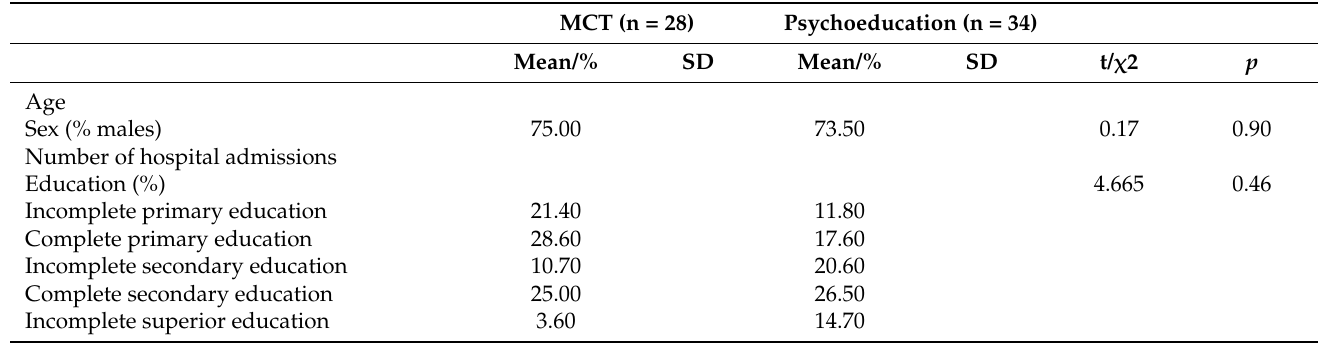
Table 1. Baseline differences in sociodemographic, clinical, social cognitive, and metacognitive variables between the psychoeducation and the MCT